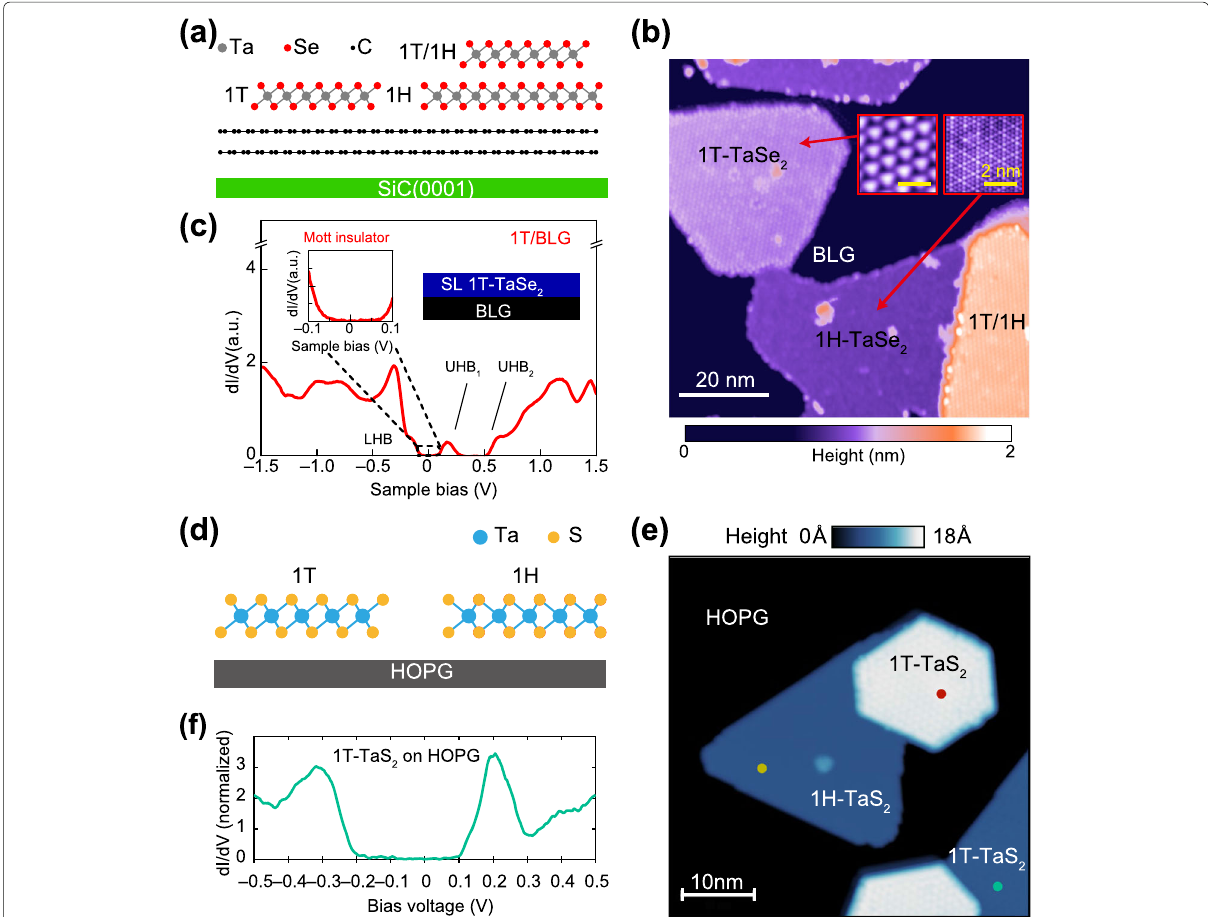
Fig. 3 Structural and electronic properties of monolayer a – c 1 T -TaSe 2 and d – f 1 T -TaS 2 . a , d Side views of the crystal structure. Monolayer 1 T -TaSe 2 films ( a ) were grown on epitaxial bilayer graphene (BLG)-terminated 6 H -SiC(0001) substrates. Monolayer 1 T -TaS 2 films ( d ) were grown on highly oriented pyrolytic graphite (HOPG). b , e STM topographies of the vertical heterostructure of monolayer 1 T -TaSe 2 and 1 T -TaS 2 . c , f dI / dV spectra of the monolayer 1 T -TaSe 2 and 1 T -TaS 2 . Taken from ref. [35,